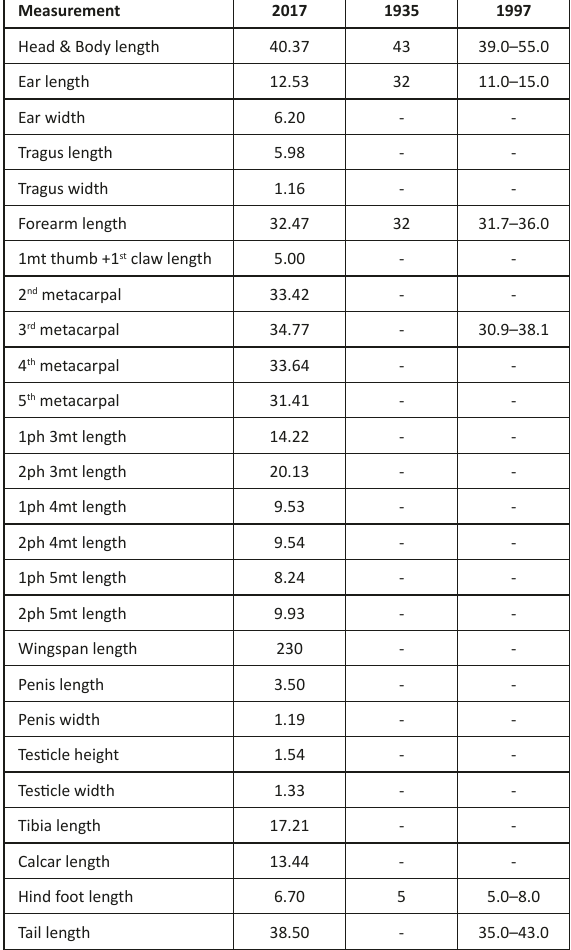
Table 1. Morphometric variables recorded on Kerivoula hardwickii specimen recorded from Thoranagoda area, Sri Lanka, in this study, and also Phillips (1935), Bates & Harrison (1997) (measurements in